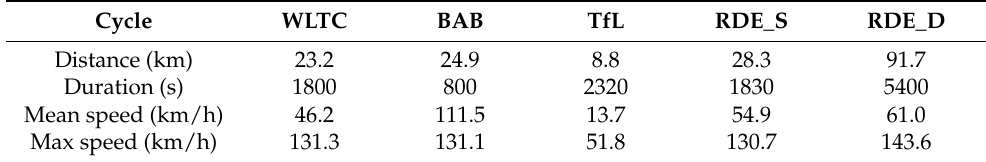
Table 3. Characteristics of the test